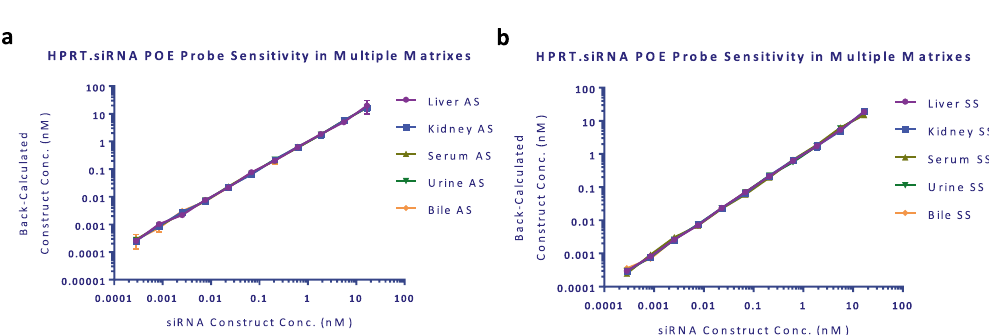
Figure 3. Calibration curve comparison in multiple Sprague Dawley matrixes for the antisense ( a ) and sense strand ( b ) versions of the POE immunoassay. Theoretical and back-calculated results were graphed in GraphPad Prism. Non-parametric Friedman test was performed using GraphPad Prism and showed no statistically significant difference at 5% significance level (p value = 0.956 and 0.847, respectively for a,b ) demonstrating no changes in calibration curves generated in different matrices. Mean data is shown with error bars representing standard